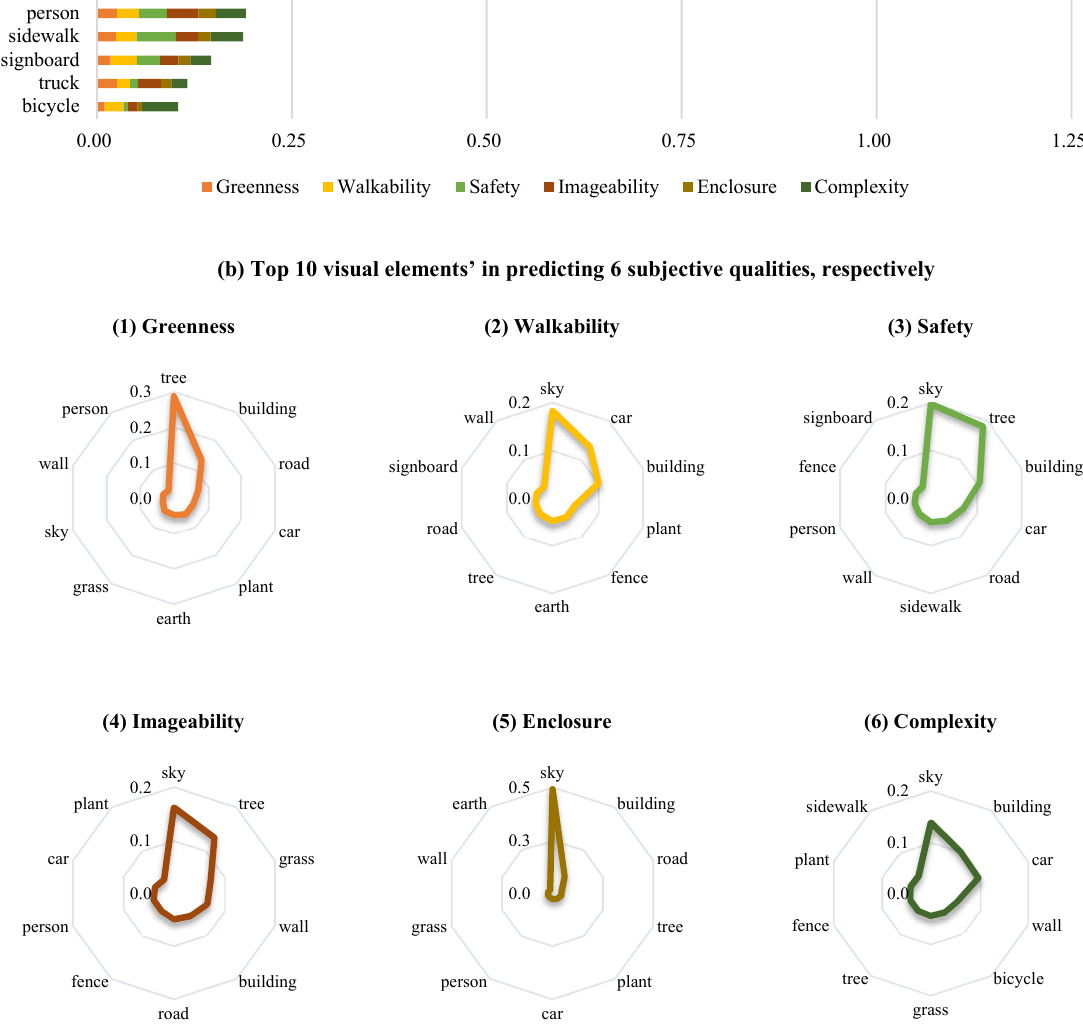
(a) Top 15 visual elements by sum and individual feature importance scores 1.25bicycletrucksignboardsidewalkpersonearthfencegrassplantwallroadcarbuildingtreesky